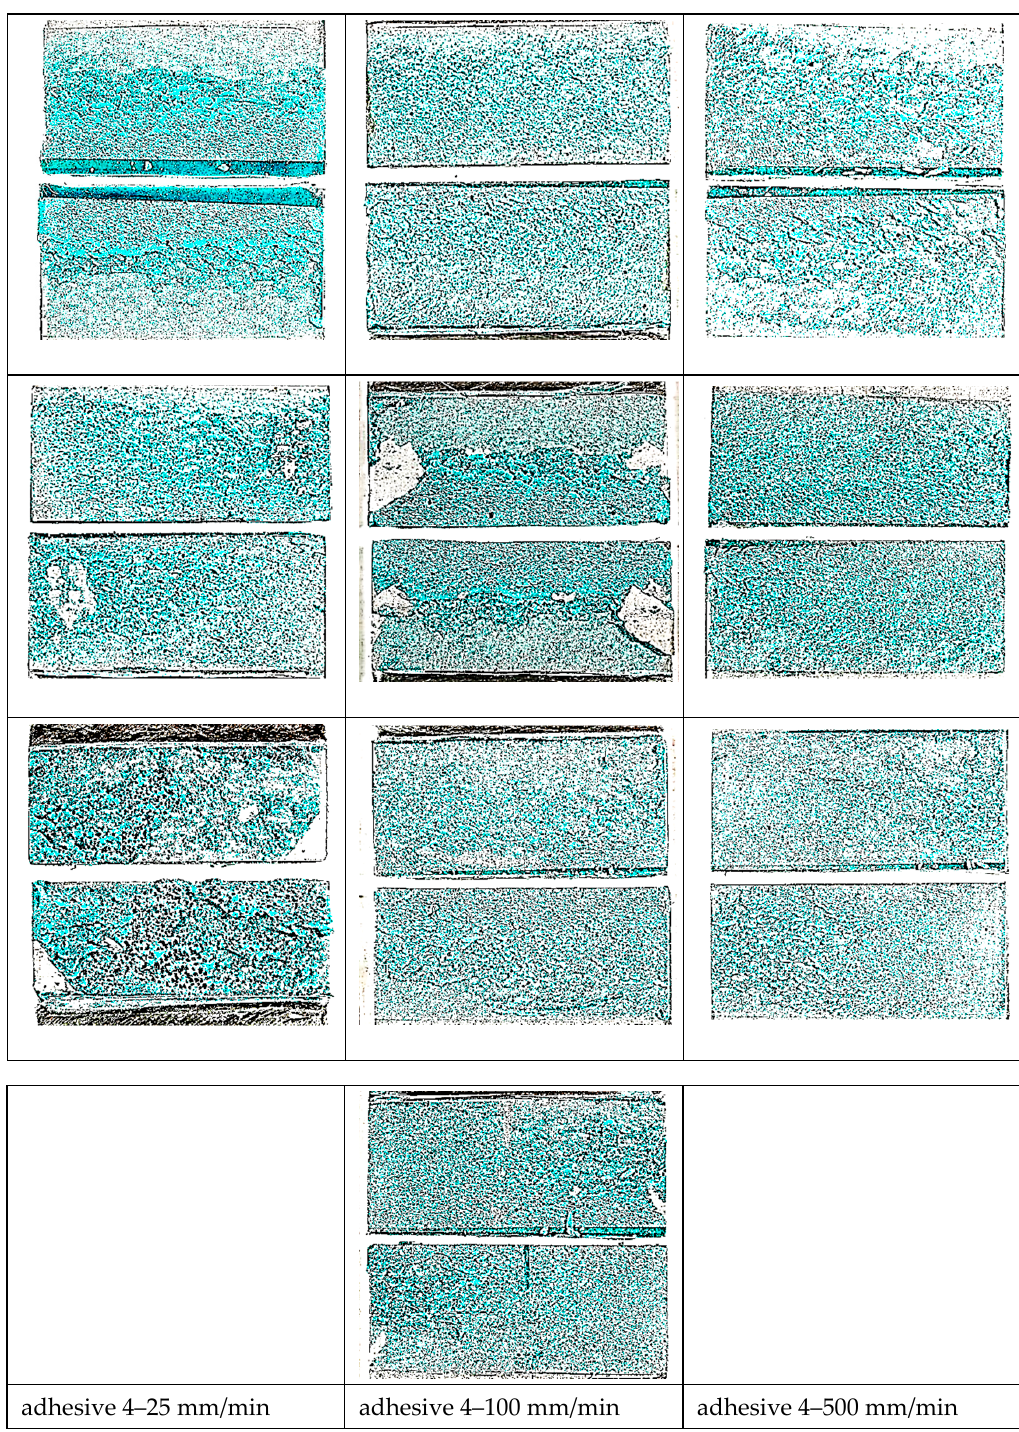
Figure 26. Failure surfaces of single lap joints bonded with adhesive 4 shown in pairs (both sides of the joint), tested at different extension rates.